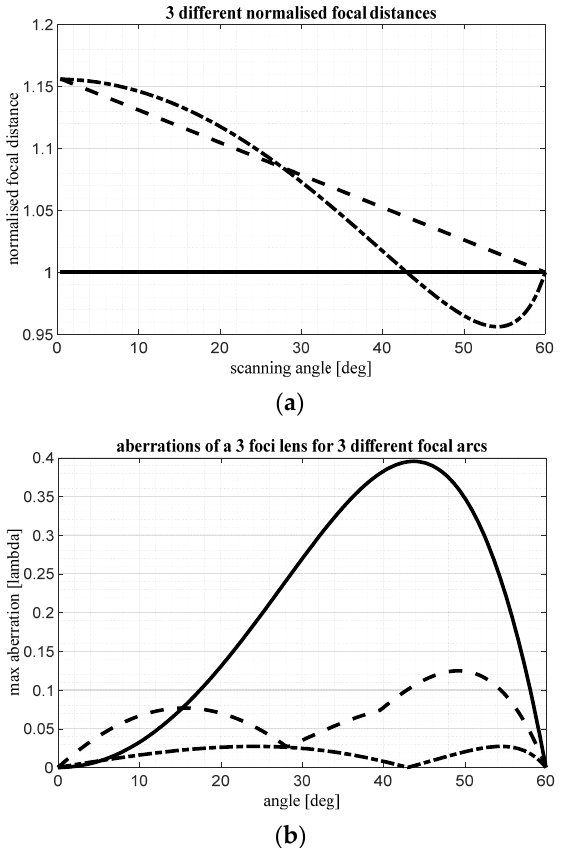
Figure 2. ( a ) Three possible focal arcs; ( b ) associated aberrations. Continuous line: circular arc; dashed line: according to Equation (2) and linear interpolation; dash-dotted line: according to Equation (2) and local optimization.